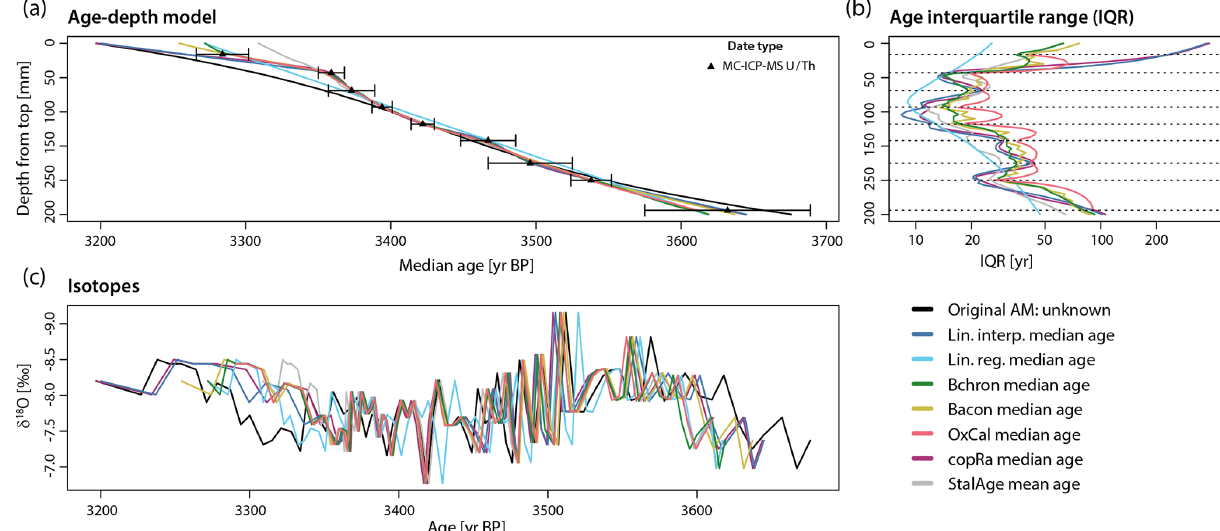
Figure 5. Illustration of the impact of the age model choice on reconstructed speleothem chronology illustrated by the KNI-51-H speleothem record (entity_id 342; Denniston et al., 2013b). Panel (a) shows the median and mean age estimates for each downcore sample from the different age models; (b) shows the interquartile range (IQR) of the ages. Dashed horizontal lines show the depths of the measured dates; (c) shows the isotopic record using the different age models.